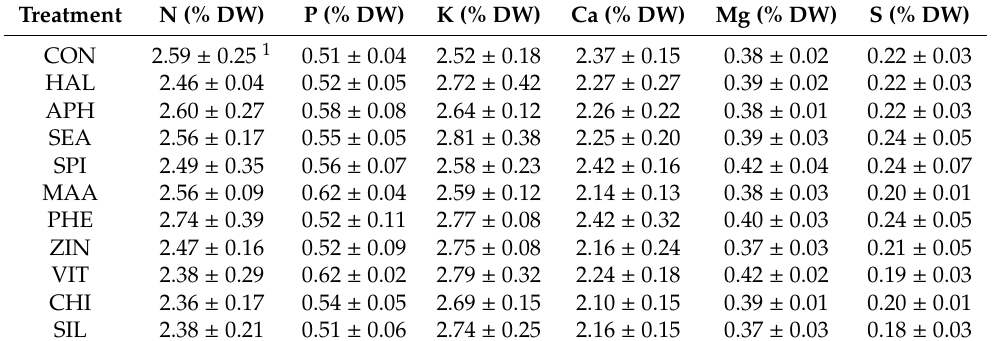
Table 5. Macronutrient concentrations in strawberry leaves at 90 DAT (days after transplanting) as a ff ected by biostimulant applications.